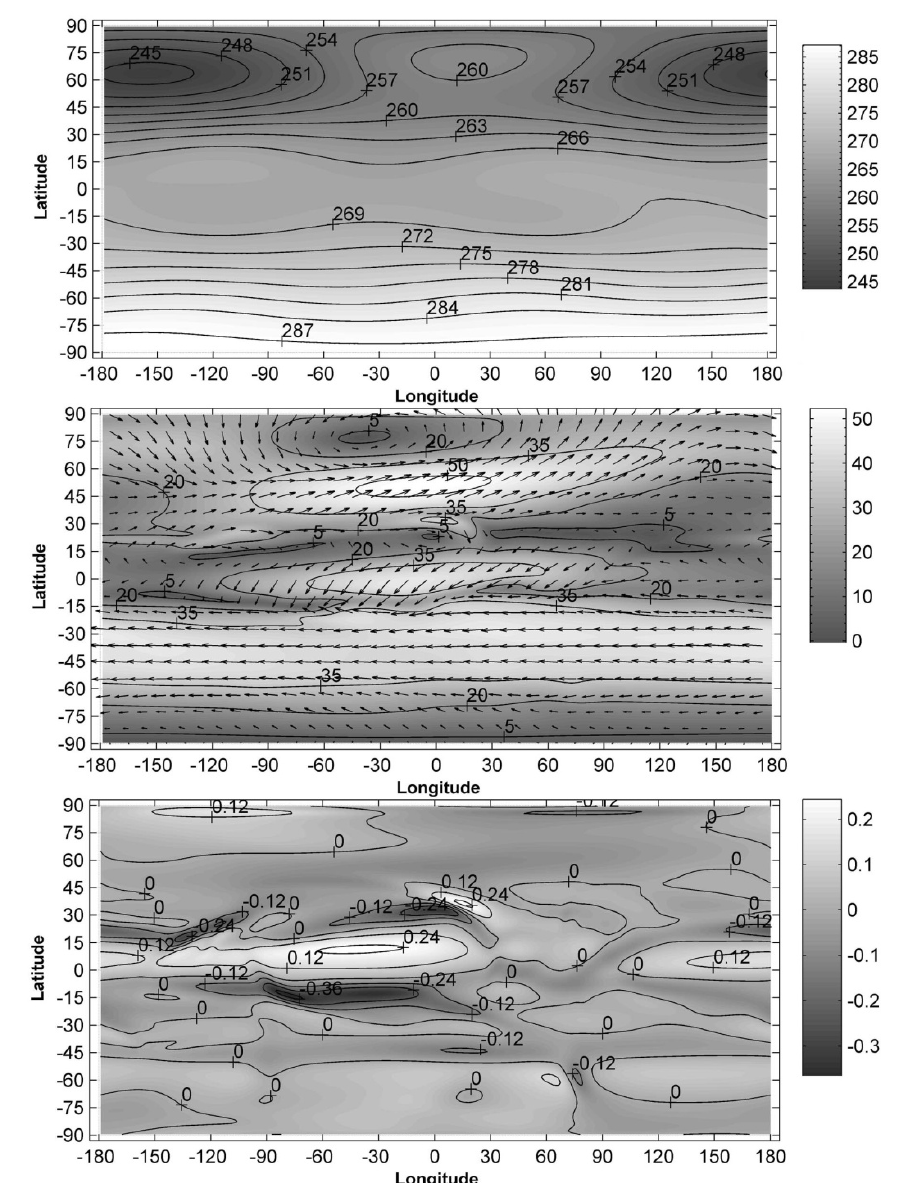
Figure 1. The distributions of the given neutral gas temperature (top panel), vector of the calculated horizontal component of the neutral wind velocity (middle panel), and calculated vertical component of the neutral wind velocity (bottom panel) as functions of longitude and latitude at the altitude of 50 km, obtained for 16 January. The temperature is given in K and wind velocities are given in m/s, with positive direction of the vertical component being